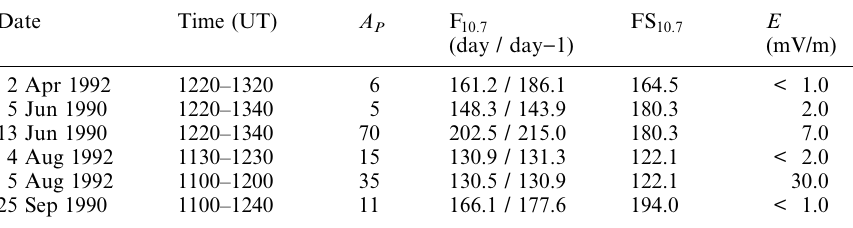
Table 2. List of the dates used in the study; FS 10.7 is a 30-day average of the solar 10.7-cm flux; E is the mean observed electric field during the indicated